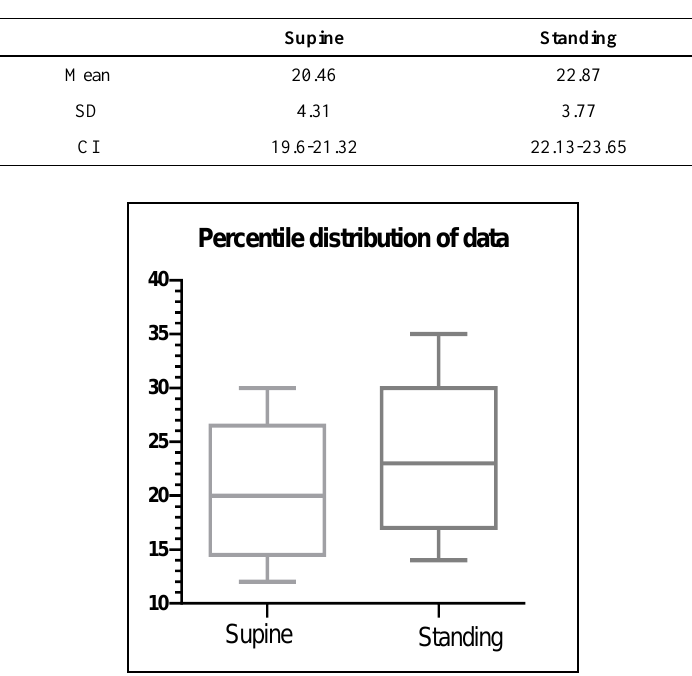
Figure 2. Percentile distribution of Q angle in supine and standing position